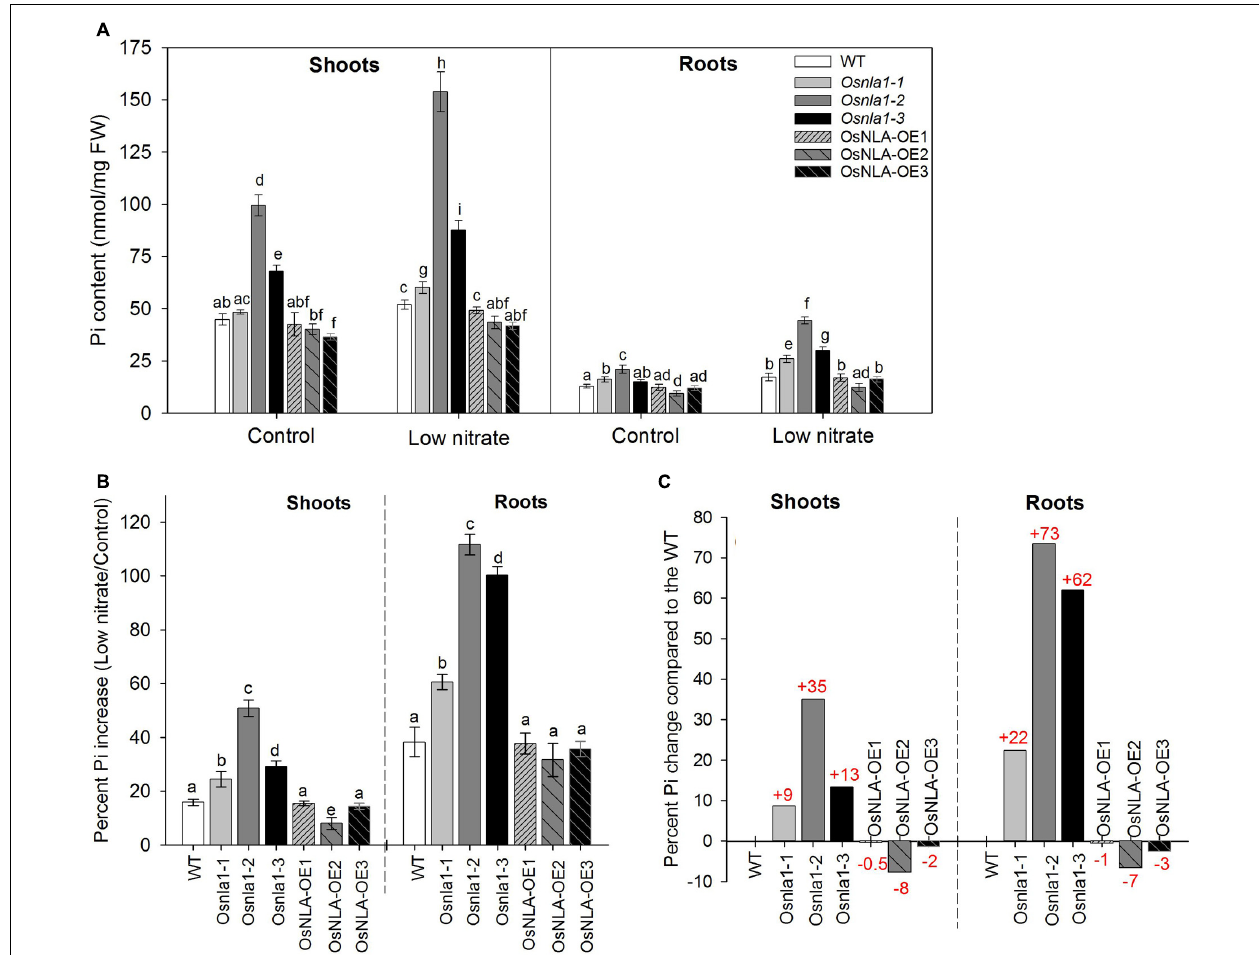
FIGURE 4 | Analysis of Pi accumulation in shoots and roots of OsNLA1 transgenic lines under sufficient and low nitrate levels. (A) Pi content of shoots and roots of wild-type, knockdown and over-expression lines, grown with sufficient (Control) and low nitrate levels in hydroponics for 4 weeks. Knockdown lines ( osnla1-1 , osnla1-2, and osnla1- 3) had the greatest Pi contents in shoots and roots, whereas, over-expression lines (OsNLA-OE1, OsNLA-OE2, and OsNLA-OE3) had the lowest. Low nitrate treatment markedly increased Pi content in both shoots and roots. (B) The percent Pi increase by low nitrate treatment compared to the control. (C) The percent Pi change of knockdown and over-expression lines by low nitrate treatment, relative to the wild-type. Different letters indicate significant differences at P ≤ 0.05 level (ANOVA, LSD test). Comparison was done for shoots and roots separately. Data are means ± SD of three to five replicates ( n =